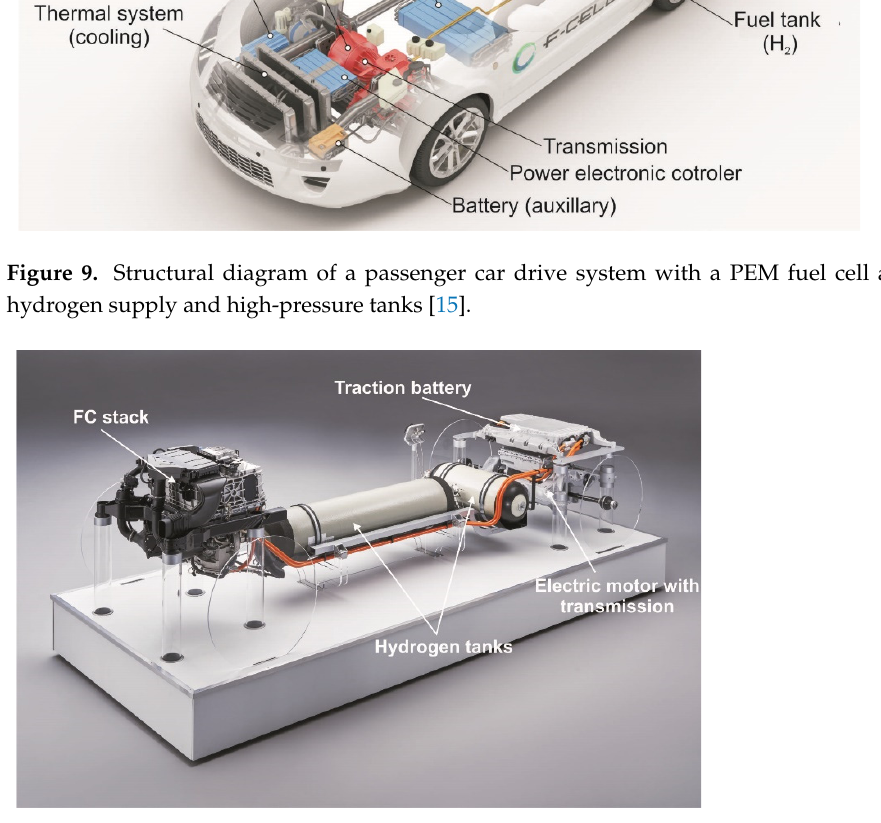
Figure 10. The main components of the BMW car drive system [21]; system power 275 kW, PEM cells power 125 kW, 6 kg of hydrogen at a pressure of 70 MPa.